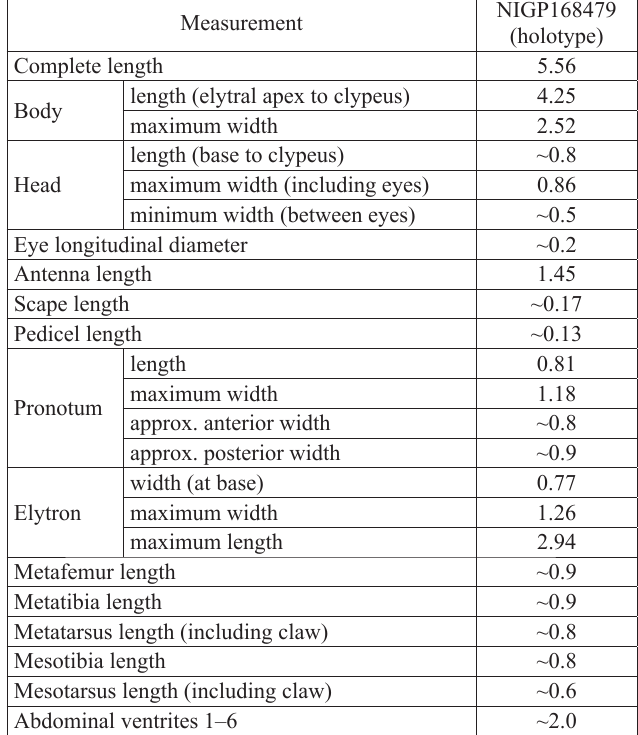
Table 3. Measurements (in mm) of visible body parts of Juraniscus majeri gen. et sp.